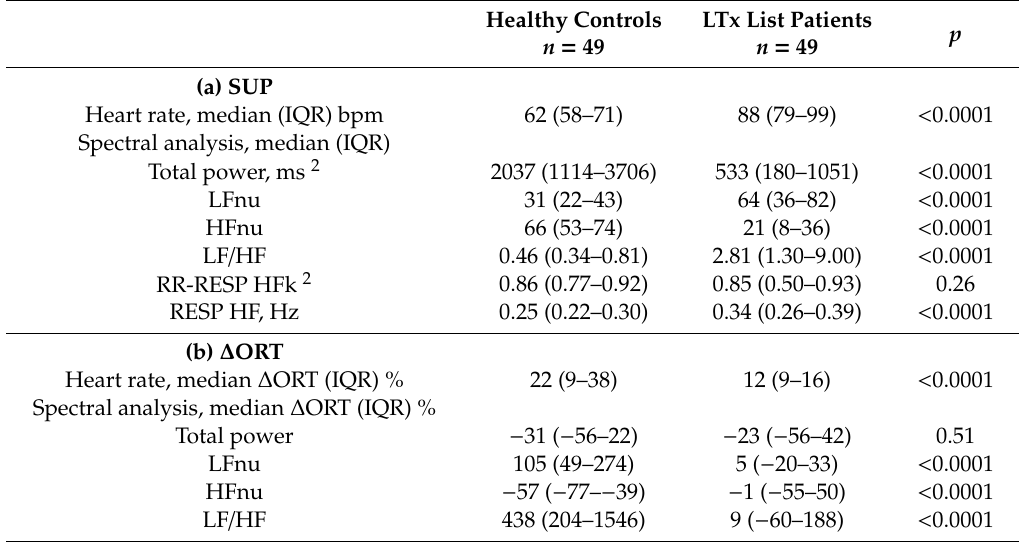
Table 2. Comparison of autonomic parameters evaluated by spectral analysis between healthy controls and patients in supine (a) and orthostatic position (b) .